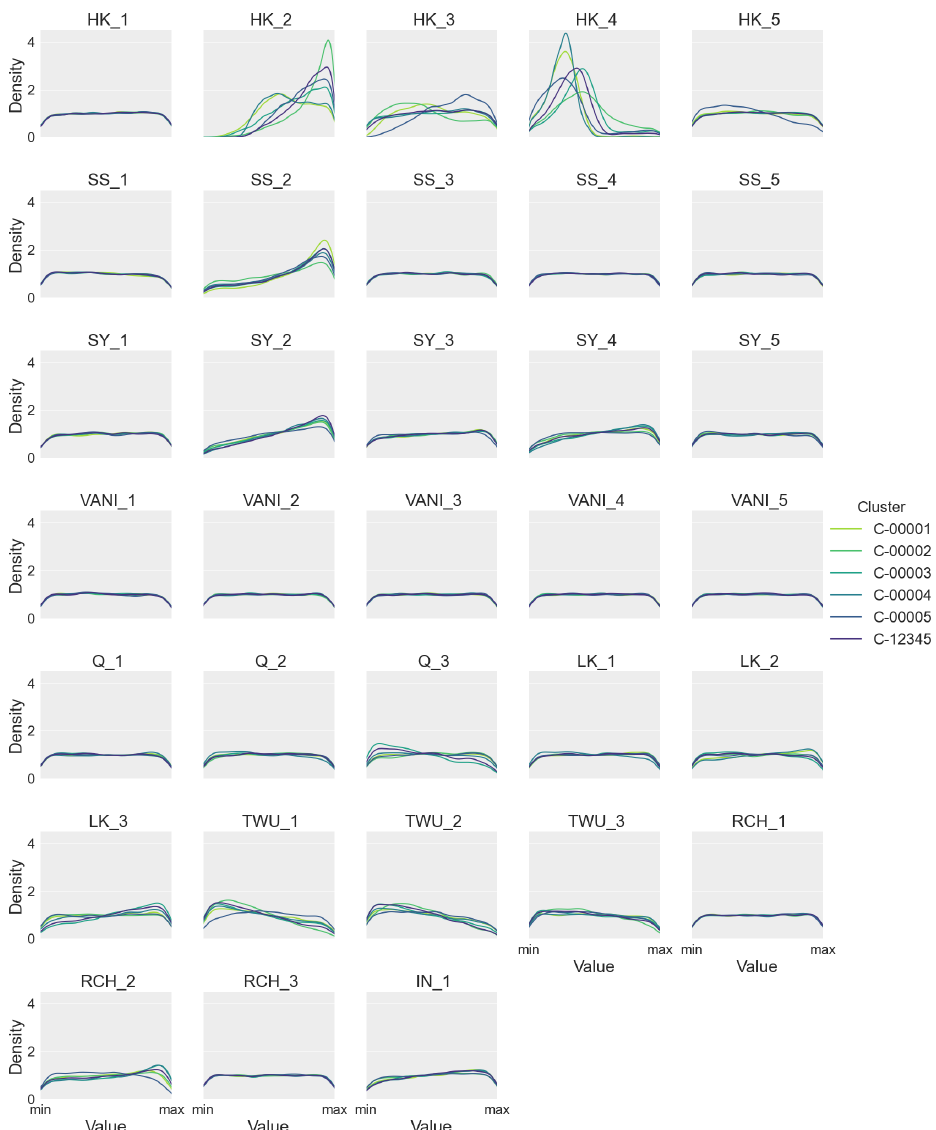
Figure 3. The distributions along the parameter ranges of the filtered samples, using the sum of squared error metric. The distributions are colored according to the observation cluster used to filter the dataset. The prior distribution (not shown) is uniform for all parameters. Parameter abbreviations are given in Table